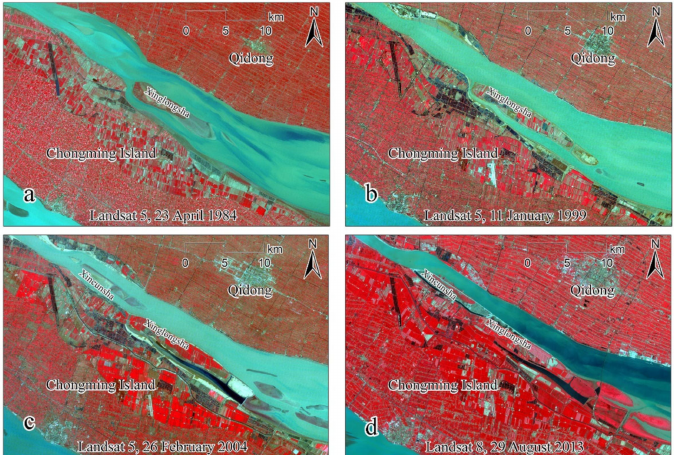
Figure 9. The formation and incorporation of Xinglongsha and Xincunsha into Chongming Island. ( a ) the Xinglongsha formed by sediment accumulation; ( b ) the Xinglongsha gradually enlarged; ( c ) the Xinglongsha merged into Chongming Island and the Xinchunsha accumulated sand; ( d ) the Xinglongsha and Xinchusha merged into Chongming Island. The background is a Landsat image with standard false color composition (near-infrared band in red, red band in green, and green band in blue), with a spatial resolution of 30